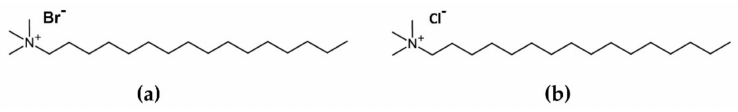
Figure 1. Chemical structure of ( a ) CTAB and ( b ) CTAC